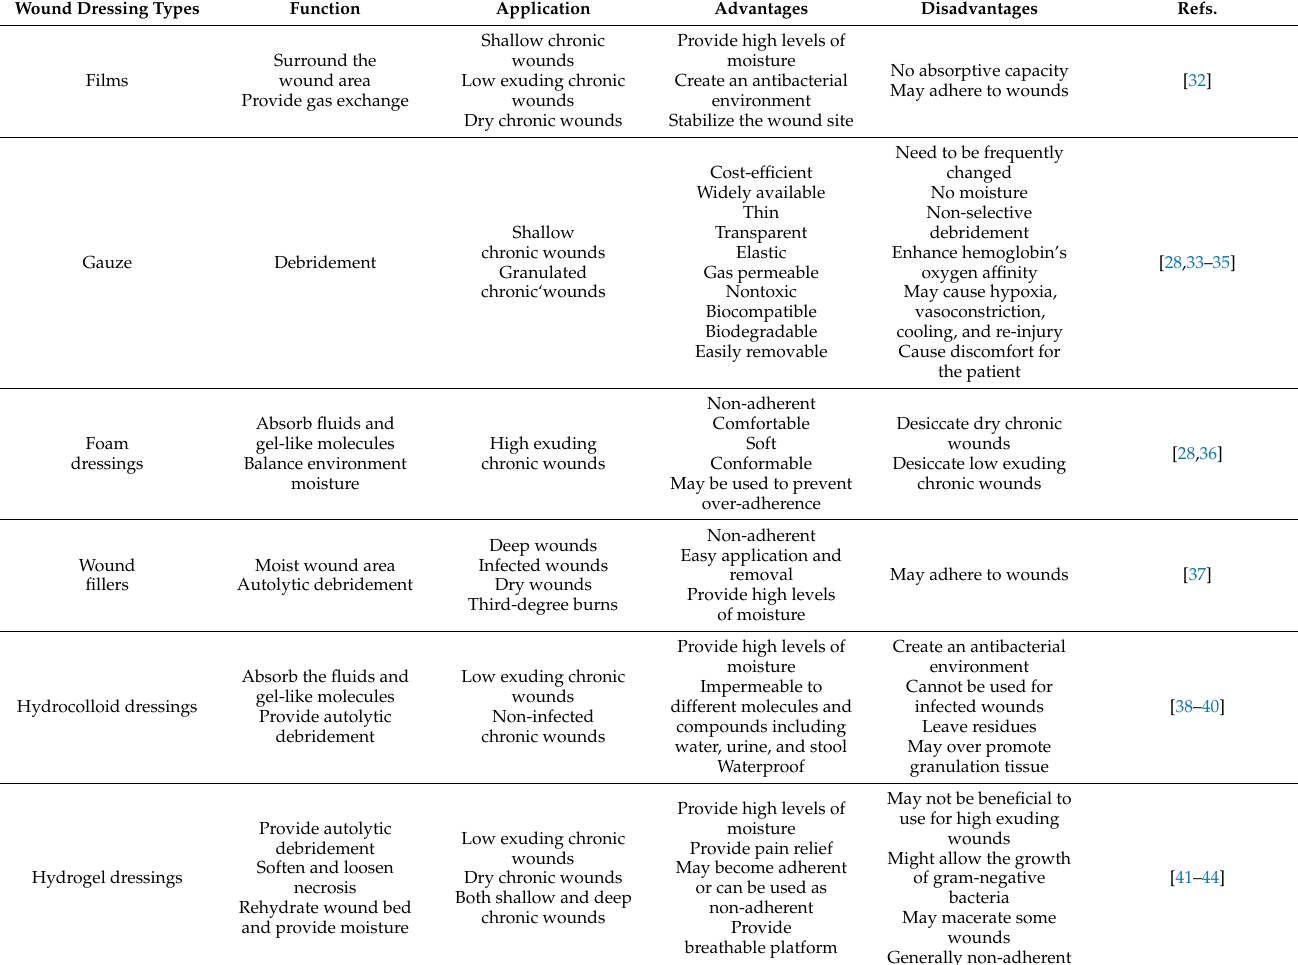
Table 3. Commonly used wound dressings for chronic